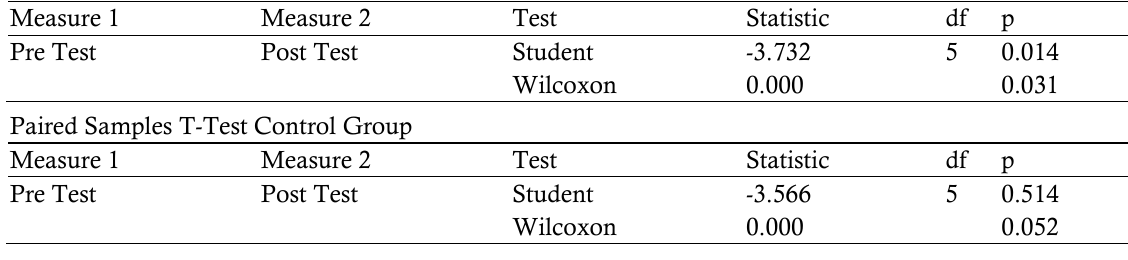
Table 4 Descriptive Statistics of Wilcoxon .